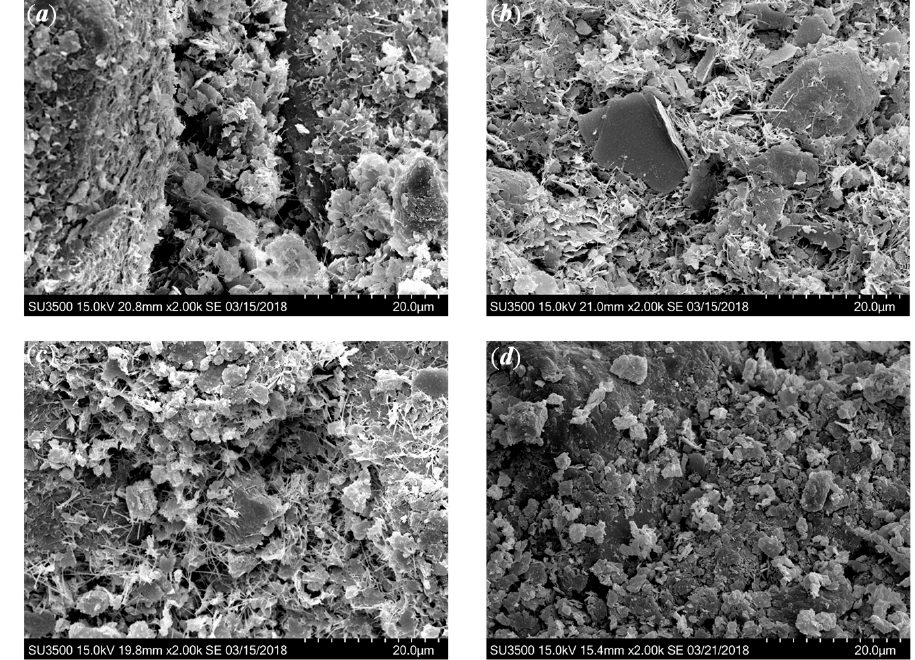
Figure 10. SEM images showing the effect of SAP: ( a ) A p = 0‰, A L = 12%, 28 days; ( b ) A p = 1‰, A L = 12%, 28 days; ( c ) A p = 0‰, A L = 12%, 90 days; ( d ) A p = 1‰, A L = 12%, 90 days.